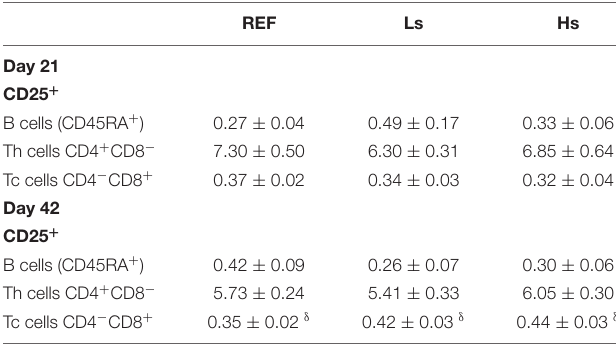
TABLE 5 | Expression of the CD25 in Th, Tc and B lymphocytes in the spleen at the end of the supplementation (day 21 of life) and 3 weeks later (day 42 of